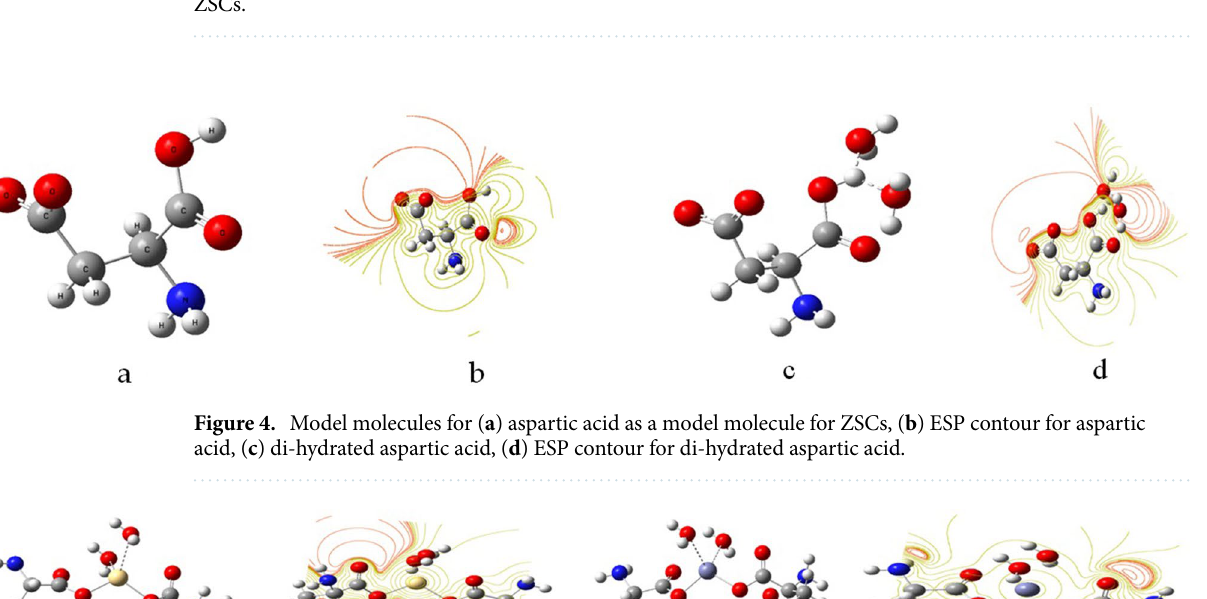
Table 2. Langmuir isotherm parameters for the biosorption of Pb(II), Zn(II) and Cd(II) onto the modified ZSCs.